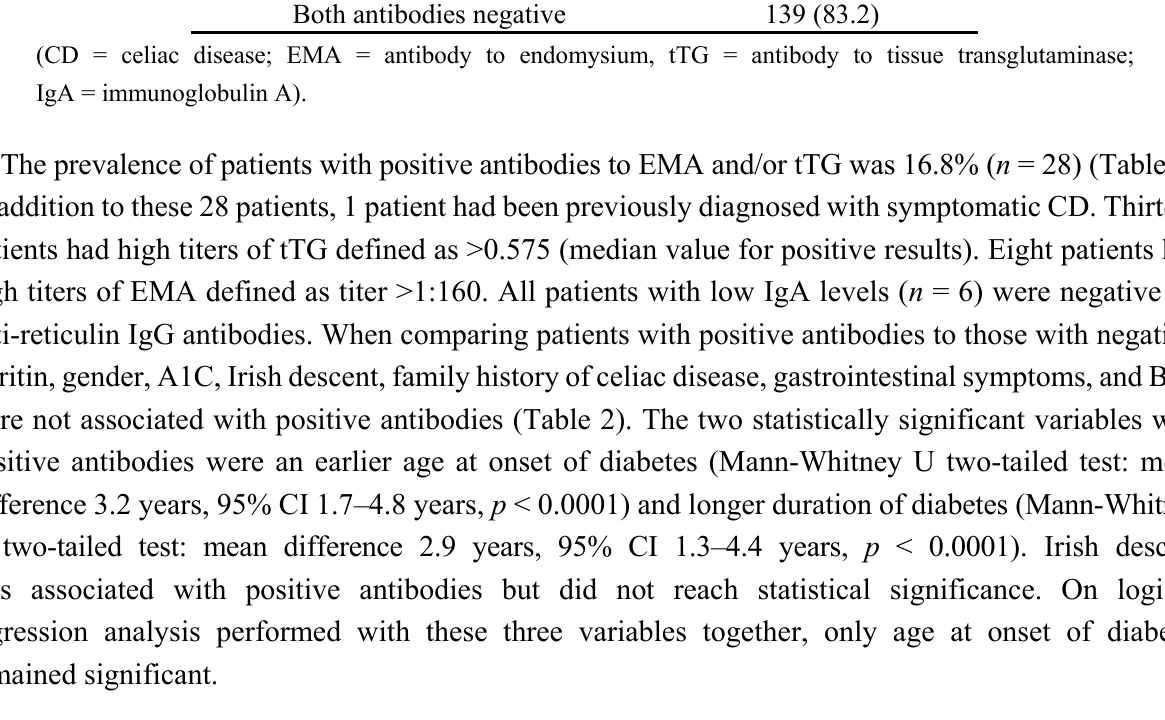
Table 2. Comparison of subjects with positive EMA-IgA and/or tTG-IgA versus those negative for these antibodies.